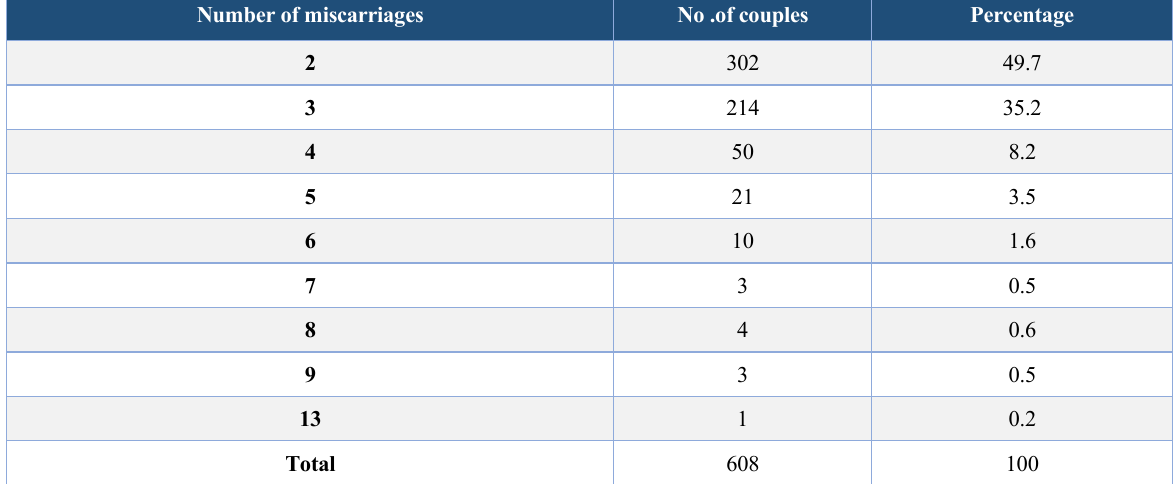
Table 1. Couples grouped according to the number of